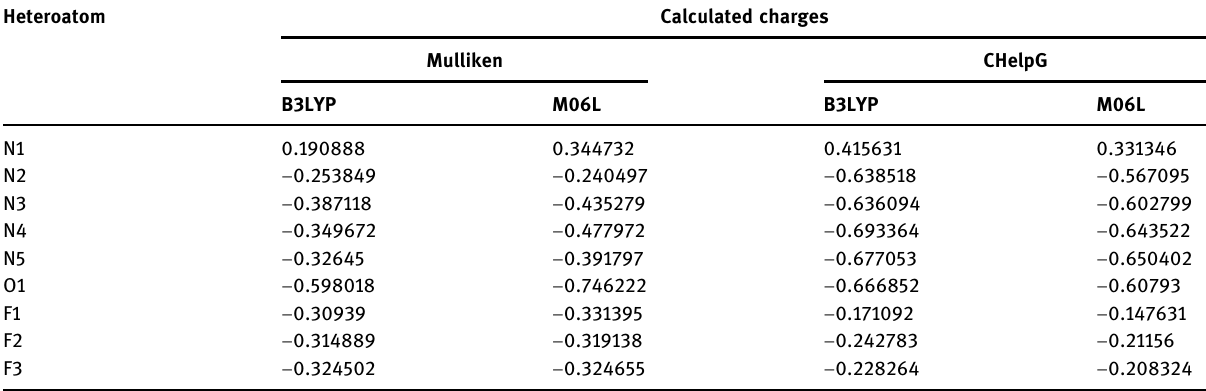
Table 1: Atomic charges [ e ] for nitrogen and oxygen atoms within the structure of voriconazole ( geometry optimized at the B3LYP/6 - 311 + G ( d,p ) or M06L/6 - 31G ( d,p ) levels of theory in gaseous phase, the Mulliken and CHelpG charge computations at the B3LYP/6 - 311 ++ G ( 2d,3p ) or M06L/6 - 311 ++ G ( 2d,3p ) levels of theory ) estimated according to the Mulliken or CHelpG methodology ( atoms numbering as in Figure 1